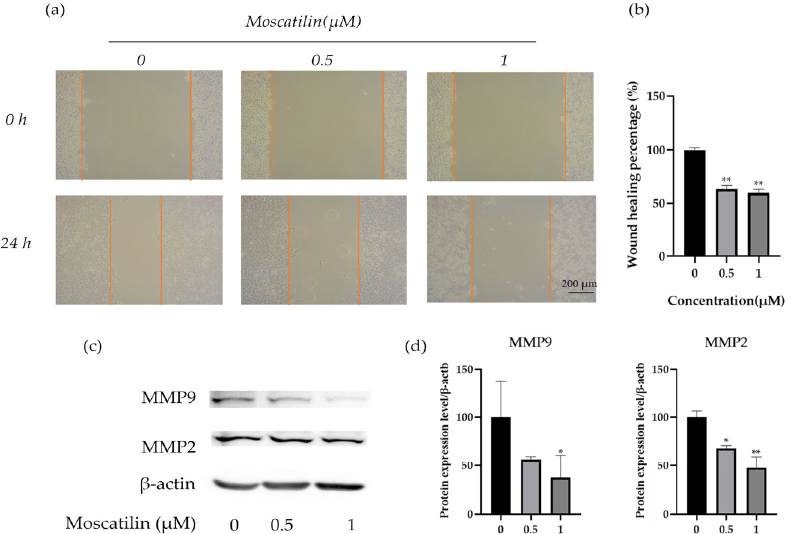
Figure 5. Effect of moscatilin on the migration of OSC-19 cells. ( a ) A wound healing assay was used to detect the migration of OSC-19 cells after moscatilin exposure. ( b ) Quantitative results were illustrated for the wound healing assay. * p < 0.05, ** p < 0.01 compared with the 0 µM group. ( c ) Western blotting assays were used to detect the protein levels of MMP2 and MMP9, and β -actin was used as a loading control. ( d ) Quantitative results were illustrated for the Western blot assay. * p < 0.05, ** p < 0.01 compared with 0 µM group.